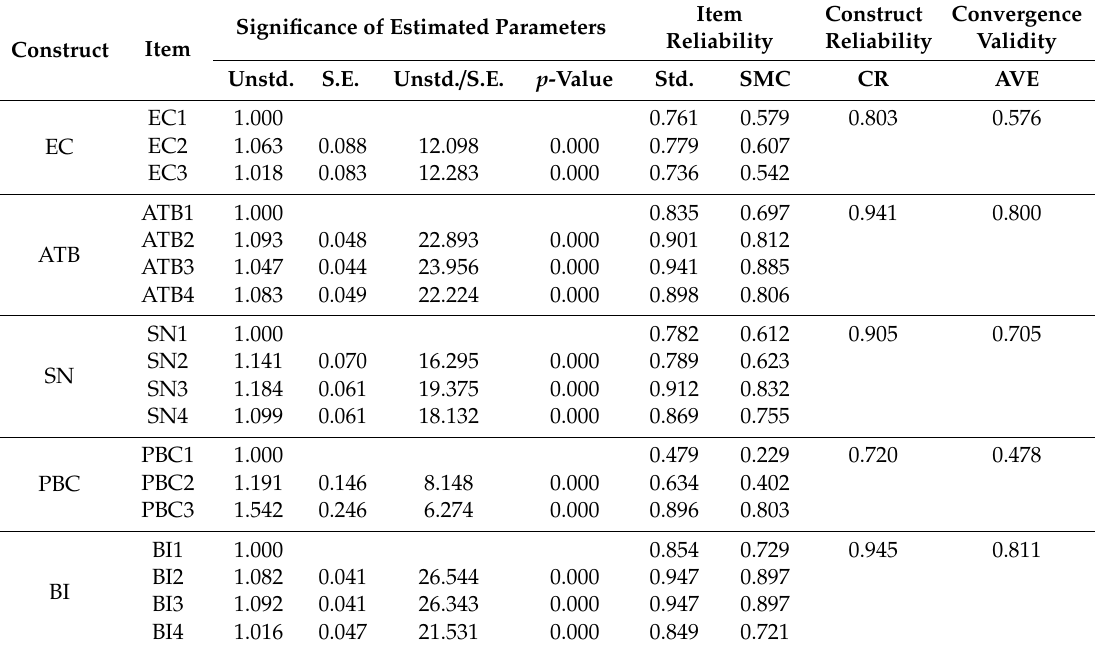
Table 4. Results for the measurement model.